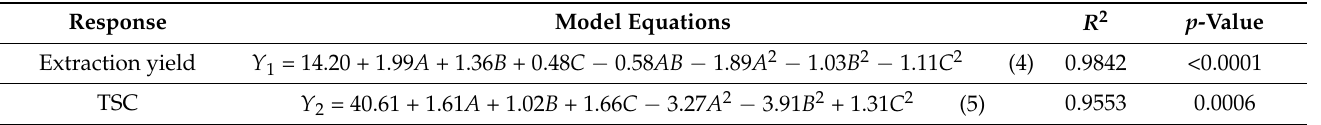
Table 4. Empirical second-order polynomial model of extraction yield and TSC content. Response Model